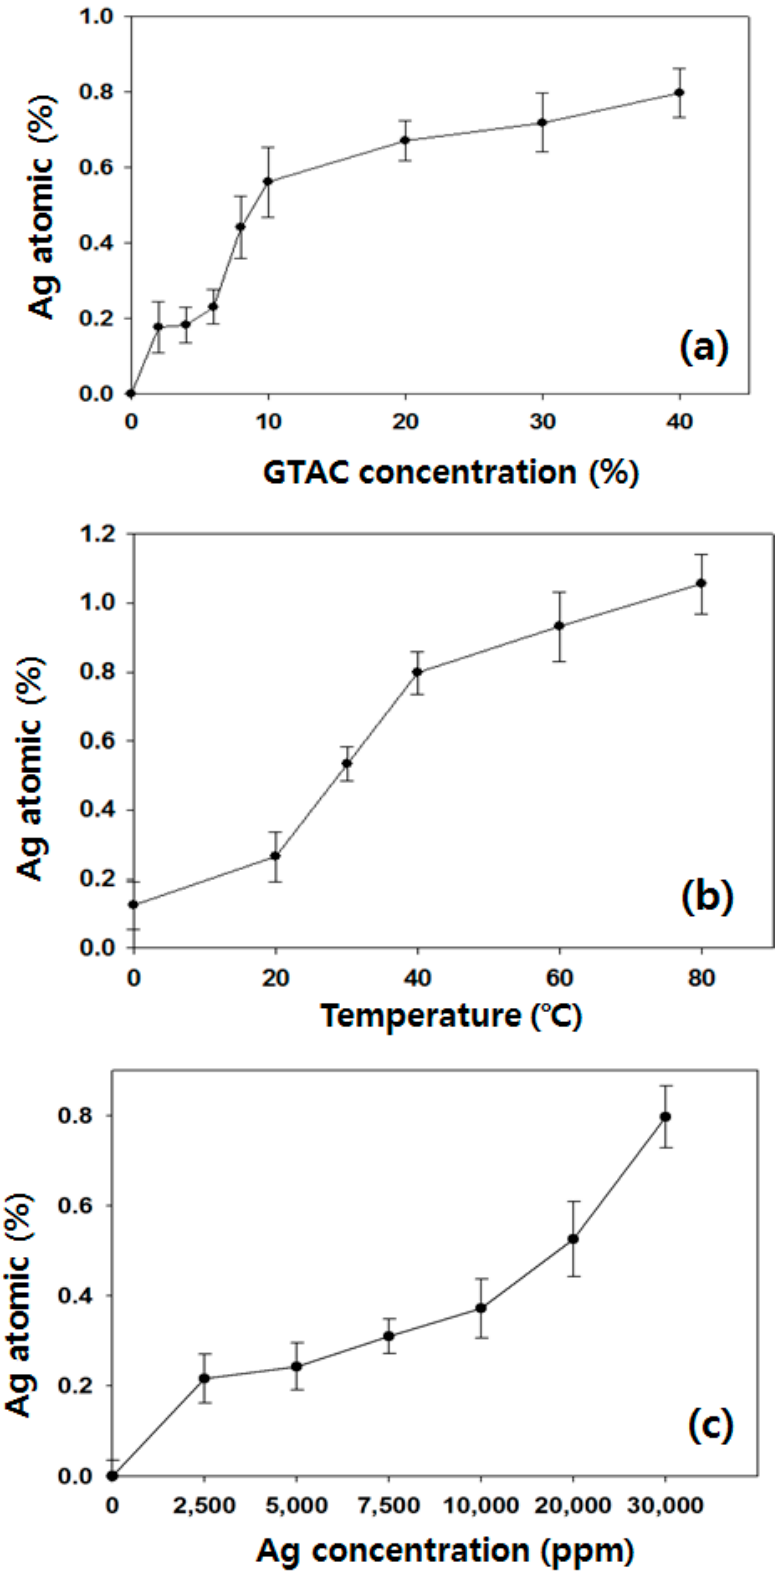
Figure 4. Ag (atomic %) on GTAC/AgNPs treated p -aramid under different ( a ) GTAC concentration; ( b ) temperature; and ( c ) Ag colloid concentration.